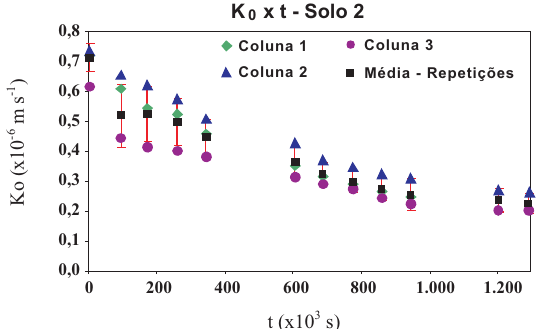
Figura 3. Condutividade hidráulica saturada em função do tempo (solo 3), média das repetições e respectivos desvios-padrão (barras verticais).